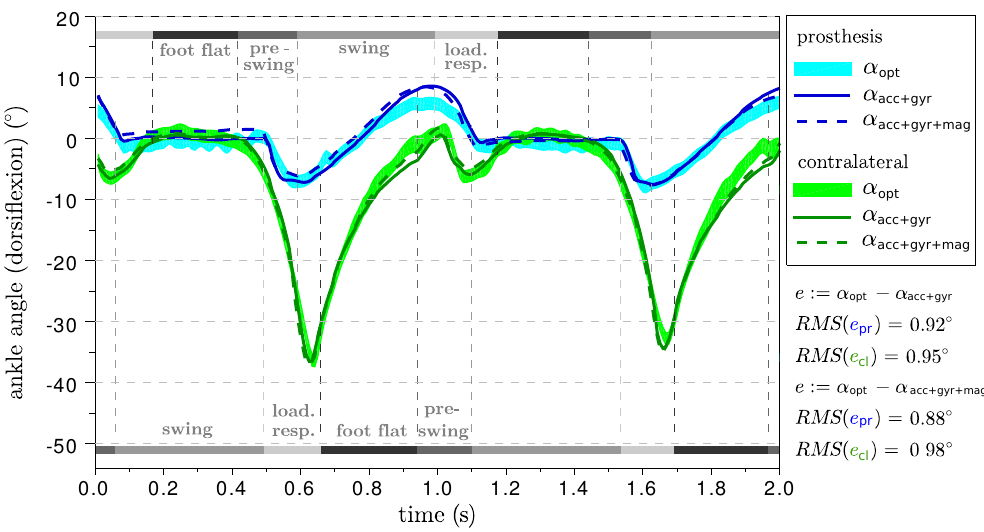
Figure 9. Comparison of the two IMU-based ankle plantar/dorsiflexion angle measurements ( t ) and α ( t ) ) with the result ( α ( t ) ) of an optical gait analysis system. ( α acc+gyr+mag acc+gyr opt Both on the prosthesis side and on the contralateral side, the deviation is about 1 ◦